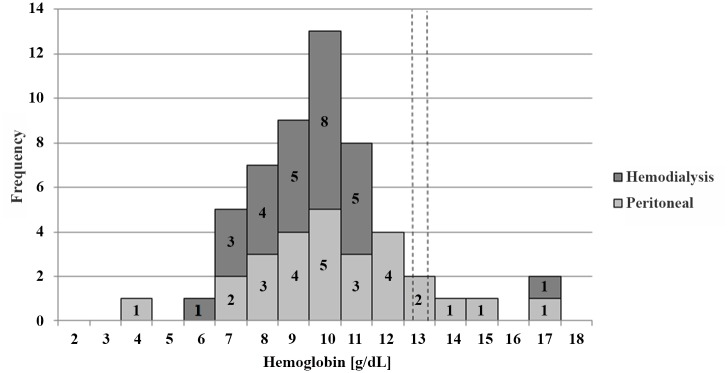
Histogram.Distribution of whole blood hemoglobin concentrations in g/dL of all patients (n = 54). Grey bars represent peritoneal dialysis patients (n = 27) and dark grey bars represent hemodialysis patients (n = 27). Vertical dashed lines show the cut-off values for hemoglobin in Guatemala for children between 5 to 12 years of age (12.2 g/dL) and children between 12 and 15 years of age (12.7 g/dL).